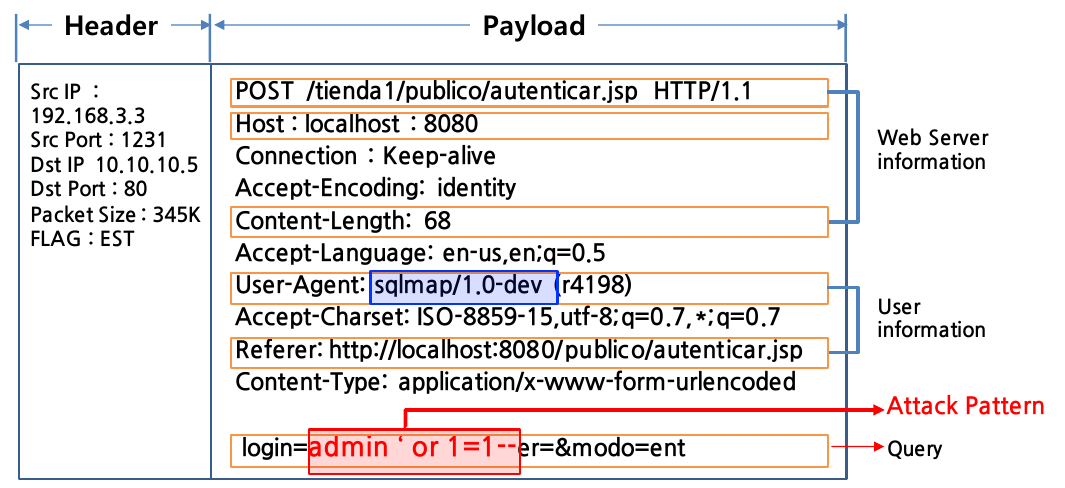
Figure 1. Example of intrusion detection